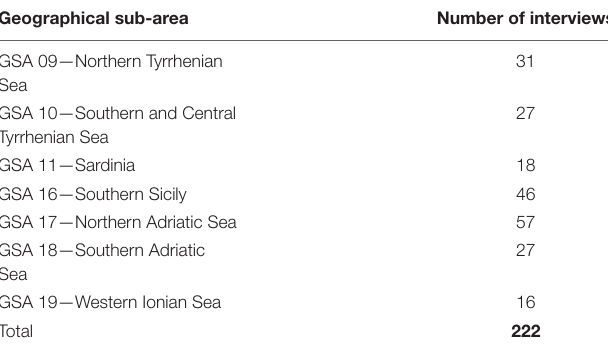
TABLE 3 | Number of vessels participating in the study according to